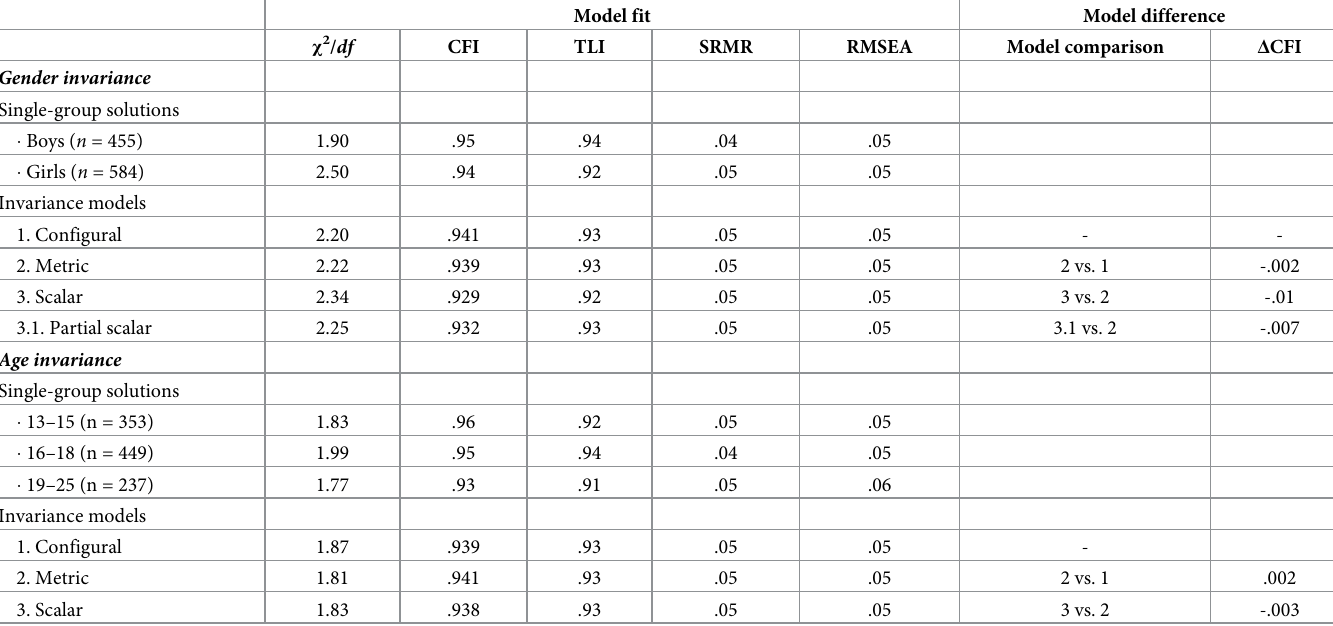
Table 7. Invariance tests of the SMU-SNS across gender and age